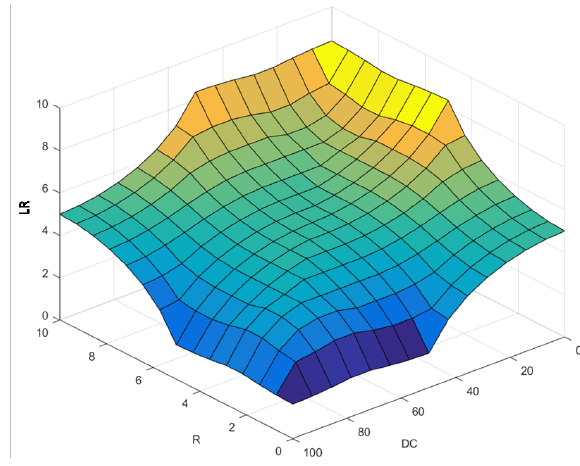
Figure 6: Surface of the Fuzzy Inference System for level